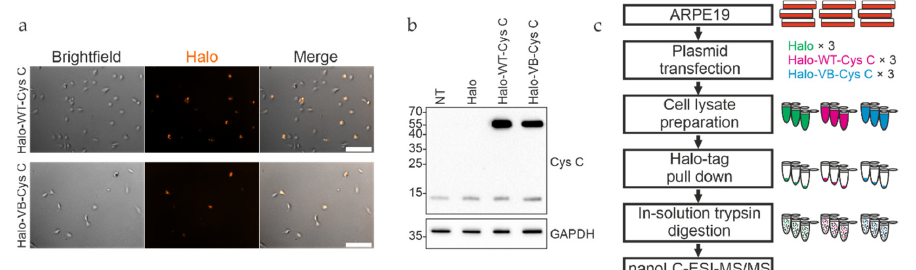
Figure 1. Expression and pull down analysis of Halo-tagged cystatin C in ARPE-19 cells. ( a ) WT and variant B (VB) cystatin C Halo-tag fusion constructs were expressed in ARPE-19 cells, followed by staining with Halo TMR Direct ligand and visualizing on a Zeiss Apotome fluorescence microscope. ( b ) Whole cell lysates of ARPE-19 cells expressing Halo-tagged WT and variant B cystatin C were analyzed by immunoblotting. Endogenously expressed cystatin C was present in all samples, alongside higher molecular weight Halo-tagged cystatin C present in the respective transfected cells. NT, non-transfected. ( c ) Schematic overview of workflow for pull down analysis of Halo-tagged fusion proteins.